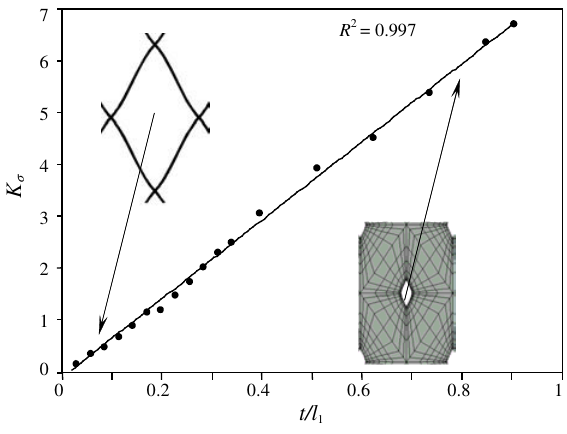
Fig 6. The influence of ratio t / l 1 on stress concentration factor K σ .; R 2 is determination